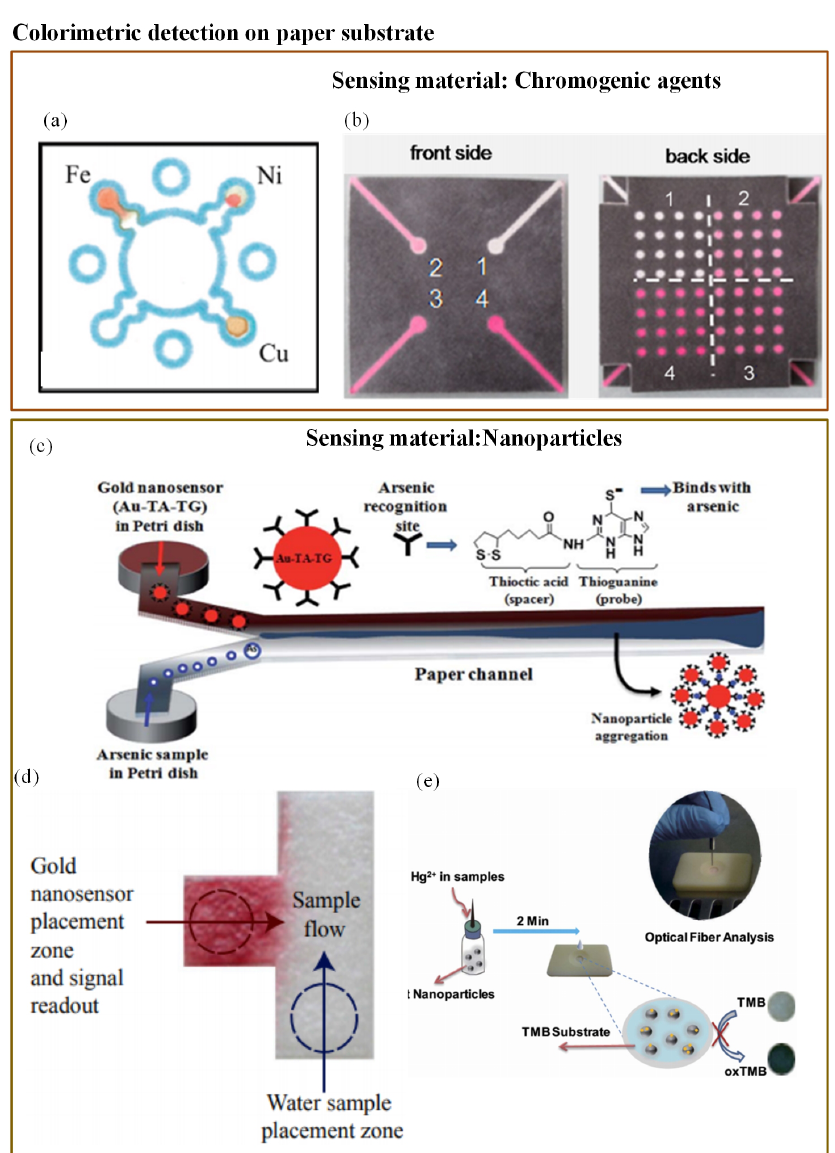
Figure 7. ( a ) Wax-printed µ PADs for colorimetric detection of Fe, Cu, and Ni [172]; ( b ) 3-D paper microfluidics for metal ion detection [138]; ( c ) working principle of As(III) detector based on modified AuNP [141]; ( d ) T-shaped µ PAD with functionalized AuNp for As(III) detection [142]; and ( e ) rapid detection of Pb 2+ with MUA-modified AuNP